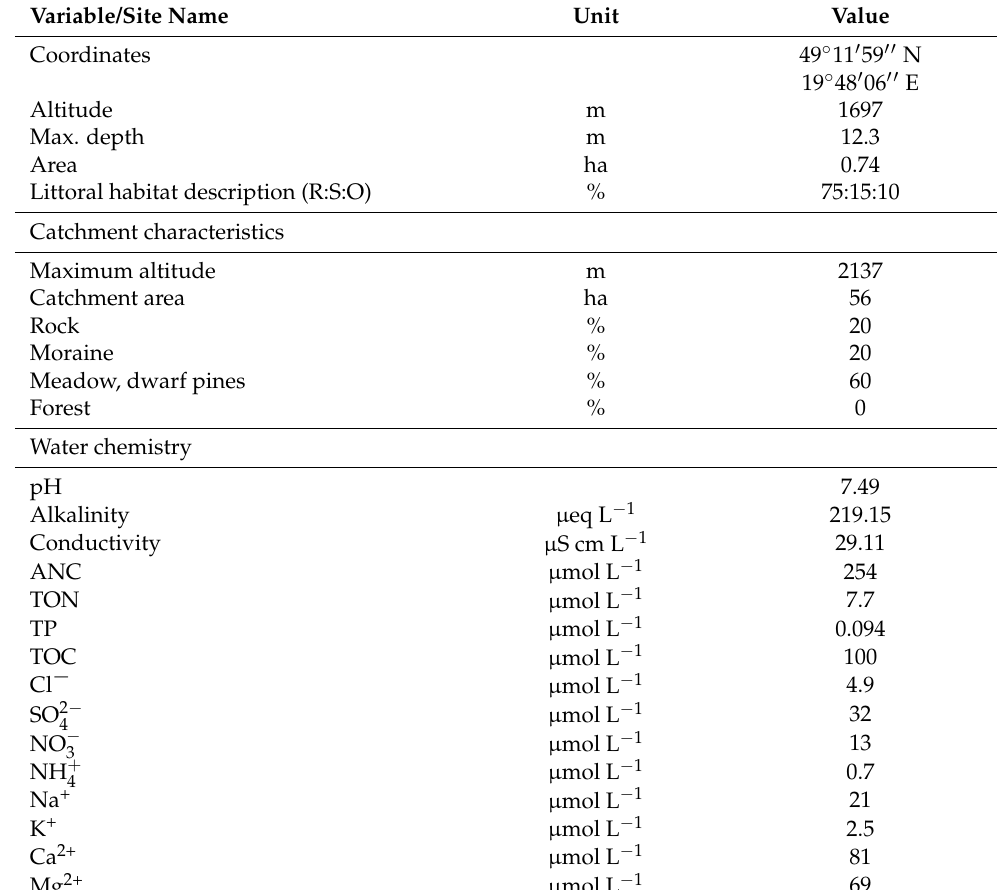
Table 1. Hydromorphological and physicochemical characteristics of the study lake, Vyšn é Raˇckovo pleso, and its catchment [16,46]. Abbreviations: R—rocks, S—sand, O—organic matter. Conductivity was measured at 20 ◦